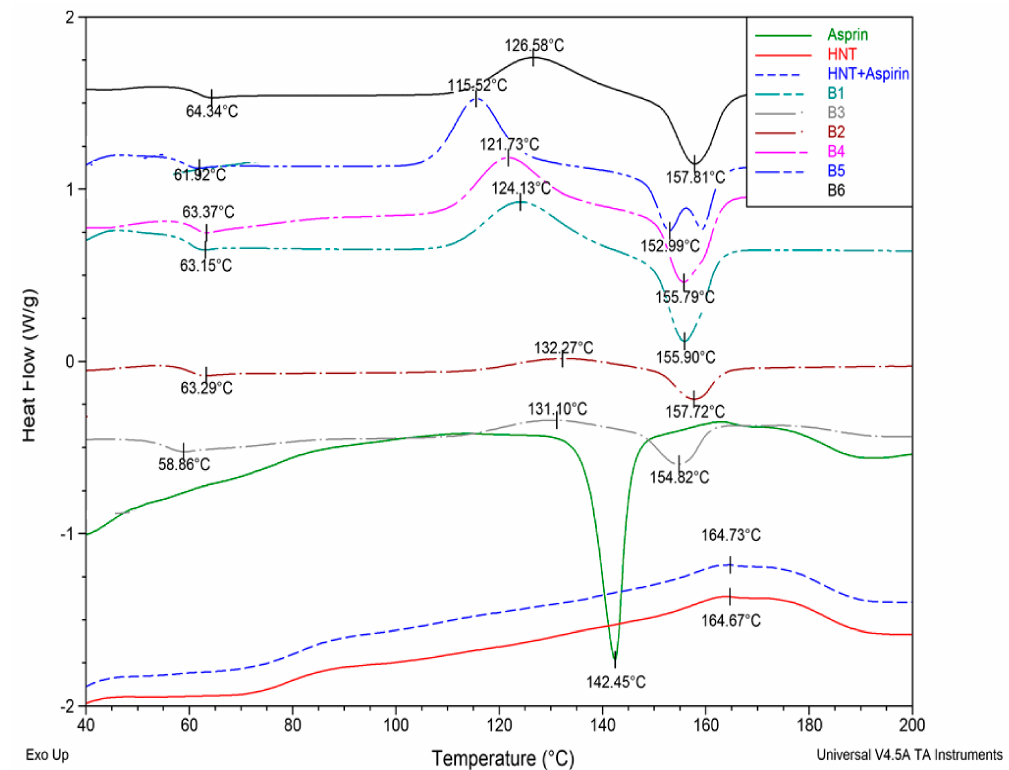
Figure 5. Thermograms of B1, B2, B3, B4, B5, B6, HNT, ASP and HNT + ASP. There is no change in T